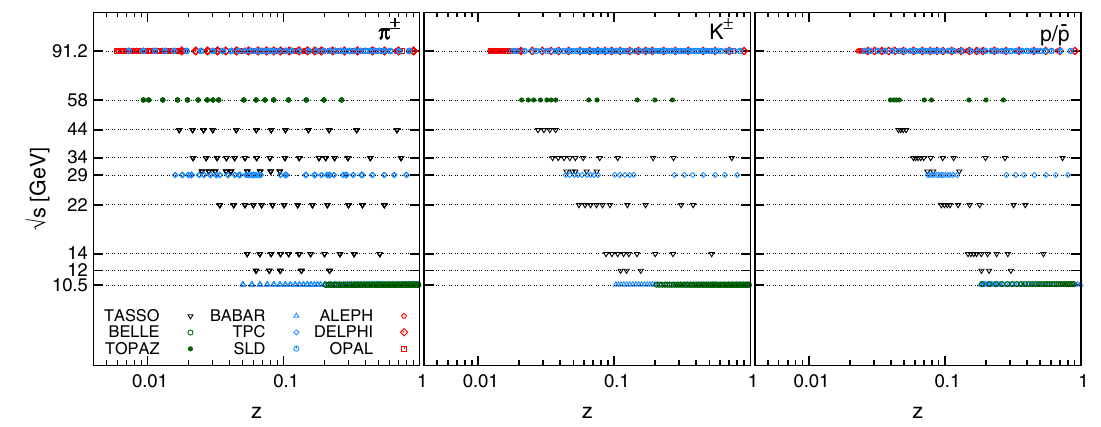
√ s ) plane of the NNFF1.0 dataset (see Table 1). Data are from DESY ( black ), KEK ( green ) and CERN